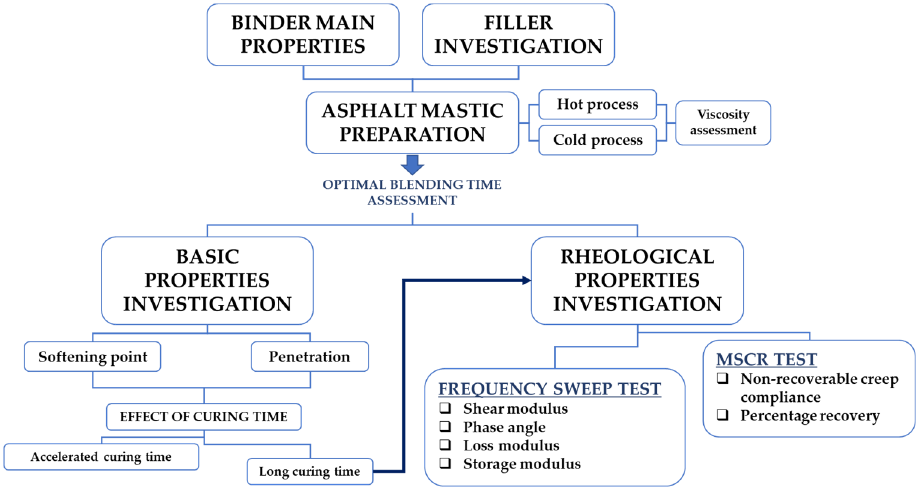
Figure 1. Summary of the main research steps.